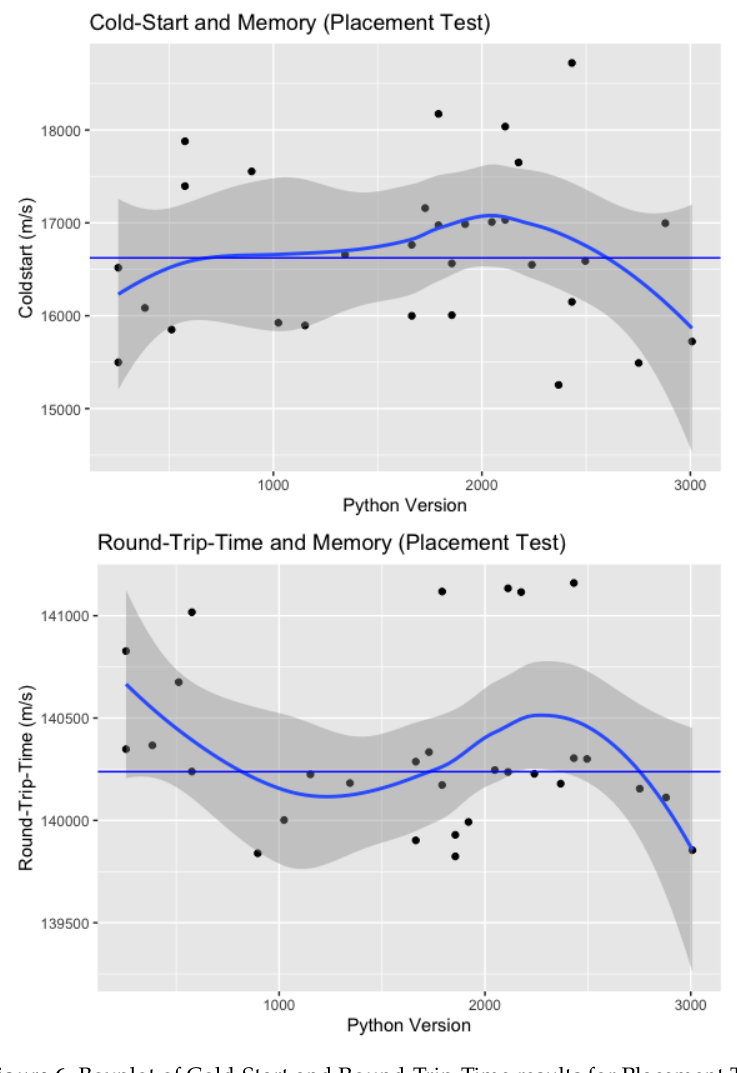
Figure 6. Boxplot of Cold-Start and Round-Trip-Time results for Placement Test. Table 5. Descriptive Statistics File Upload